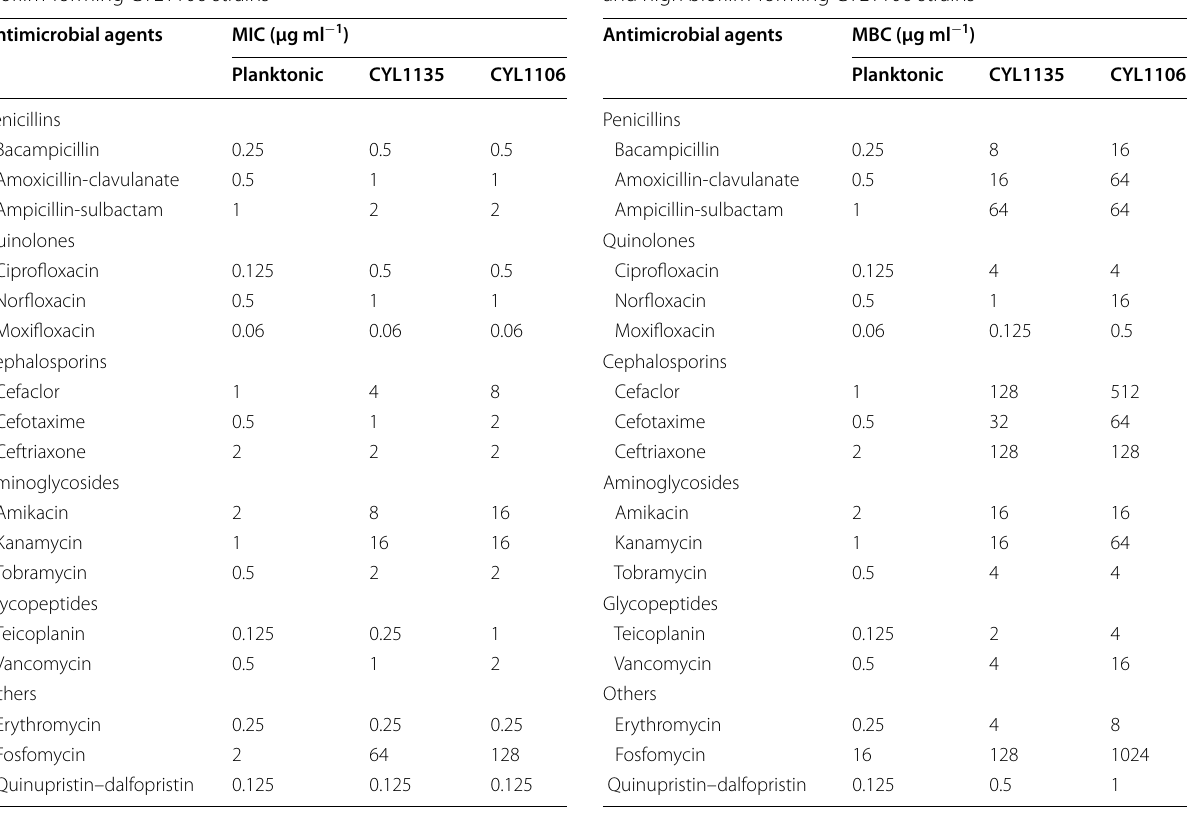
Table 1 Minimum inhibitory concentrations (MICs) of antibiotics Table 2 Minimum bactericidal concentrations (MBCs) of antibiotics in planktonic S. aureus , low biofilm‑forming